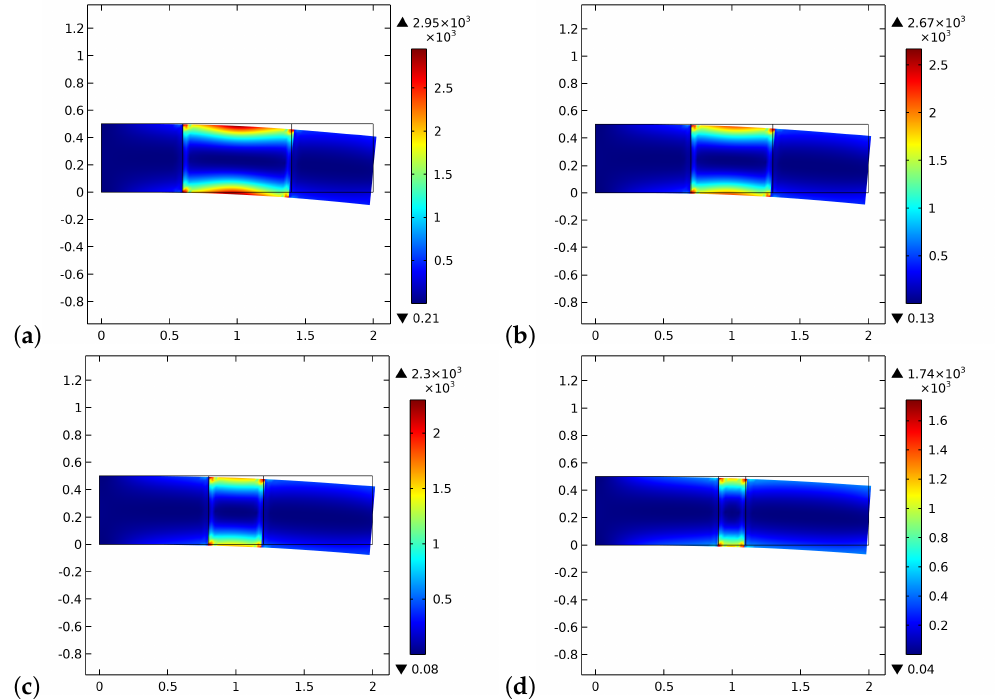
Figure 11. The distribution of the dissipated energy density at the end of the time of simulation for different substitute lengths of the graft: ( a ) 0.8 cm. ( b ) 0.6 cm. ( c ) 0.4 cm. ( d ) 0.2